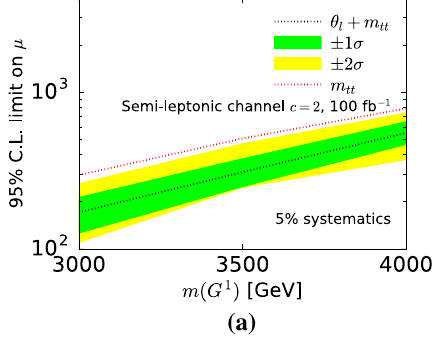
in the text ) as a function of resonance mass using m ( t ¯ t ) and cos θ l ± ( black line ) and only using m ( t ¯ t ) ( red line ). The ± σ bands are for the combined